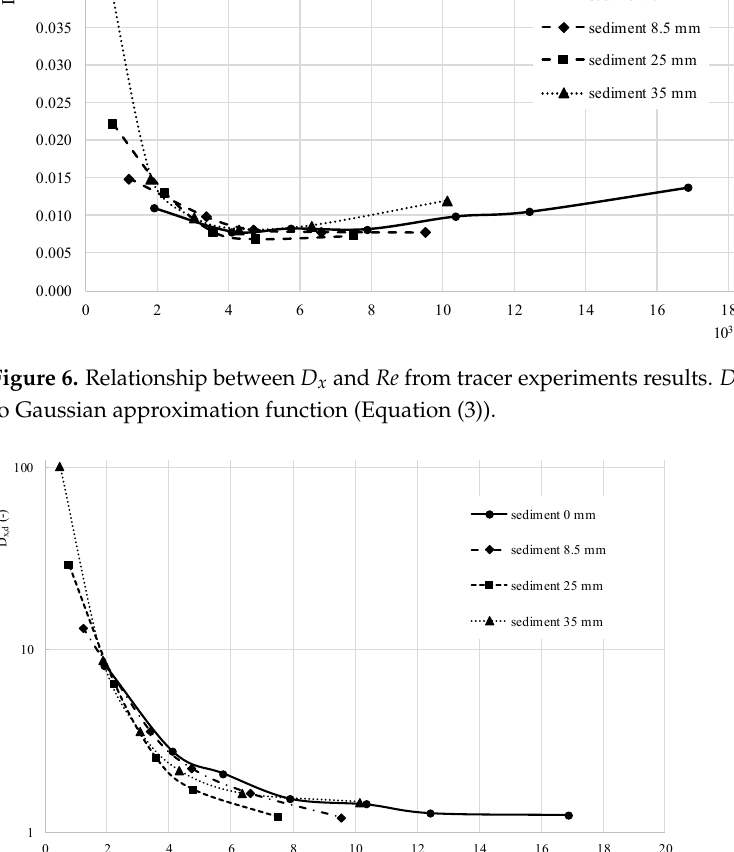
Figure 7. Relationship between D x,d and Re from tracer experiments results. D x is evaluated according to Gaussian approximation function (Equation (3)).